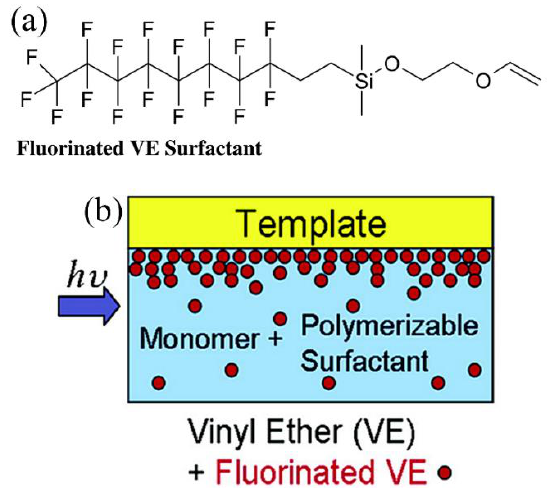
Figure 9. ( a ) Structure of the vinyl ether (VE) monomers; ( b ) segregation of the surfactant molecules to the polymer resist–mold interface. Reprinted with permission from [100]. Copyright 2007 American Chemical Society.